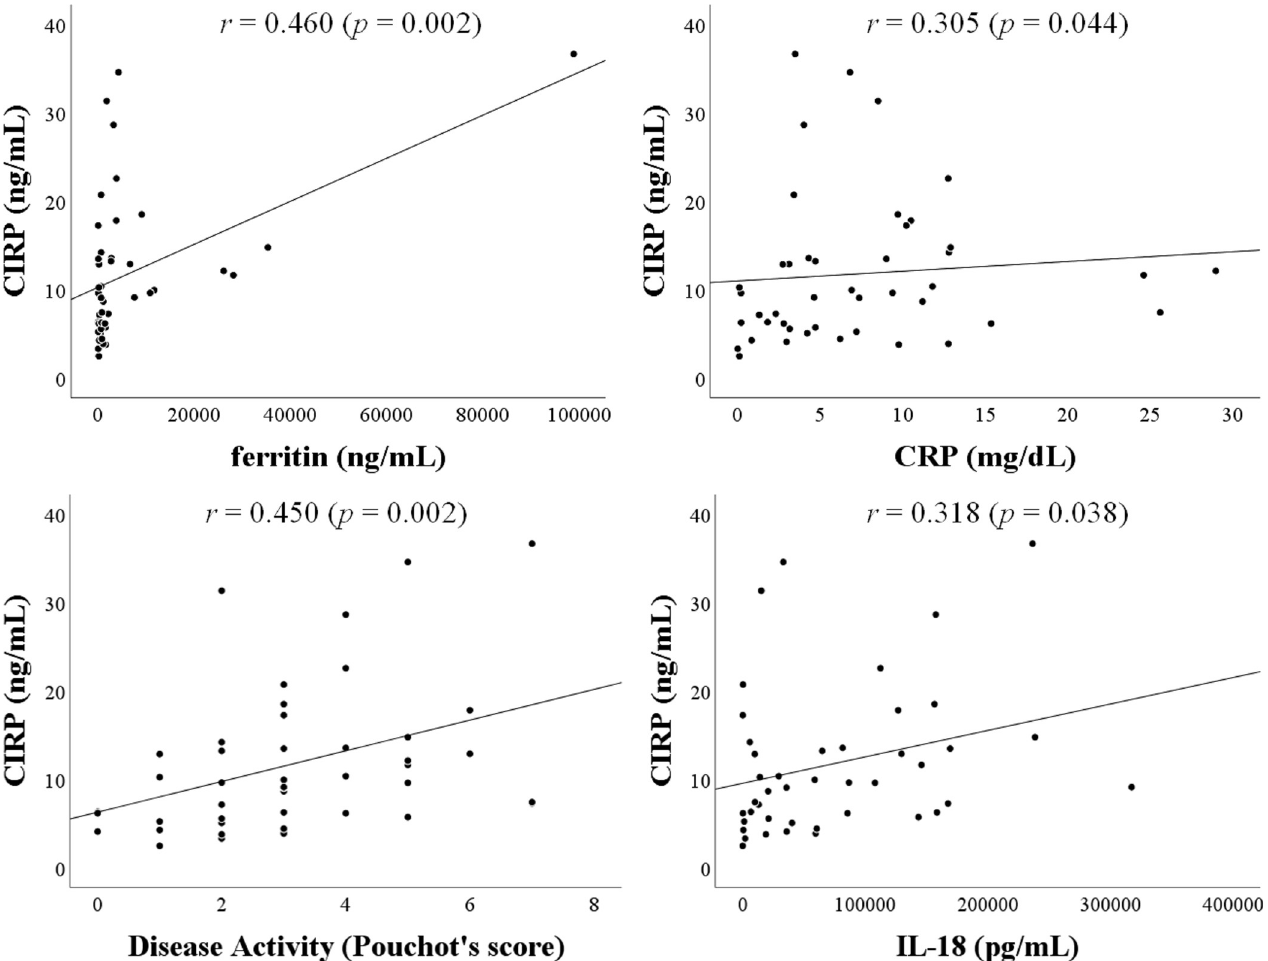
Fig 3. Relationship between serum levels of CIRP and clinical parameters in patients with AOSD. A. Correlation analysis of serum levels of CIRP and ferritin showed a significant positive correlation in AOSD patients. B. Correlation analysis of serum levels of CIRP and CRP did not show a significant correlation in AOSD patients. C. Correlation analysis of serum levels of CIRP and disease activity scores (Pouchot’s score) showed a significant positive correlation in AOSD patients. D. Correlation analysis of serum levels of CIRP and IL-18 showed a significant positive correlation in AOSD patients.